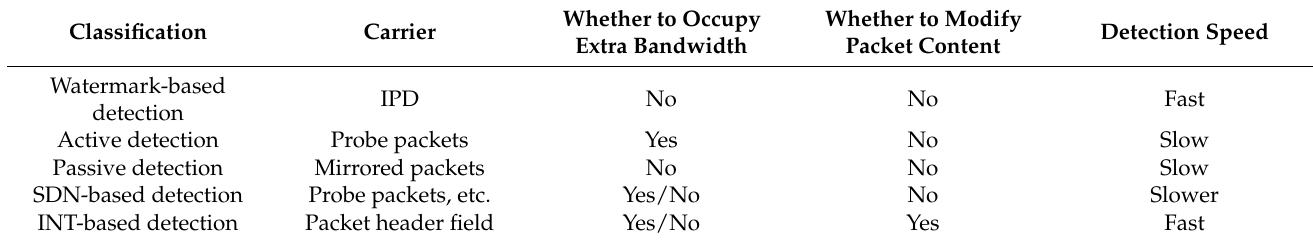
Table 1. Comparison of network congestion detection